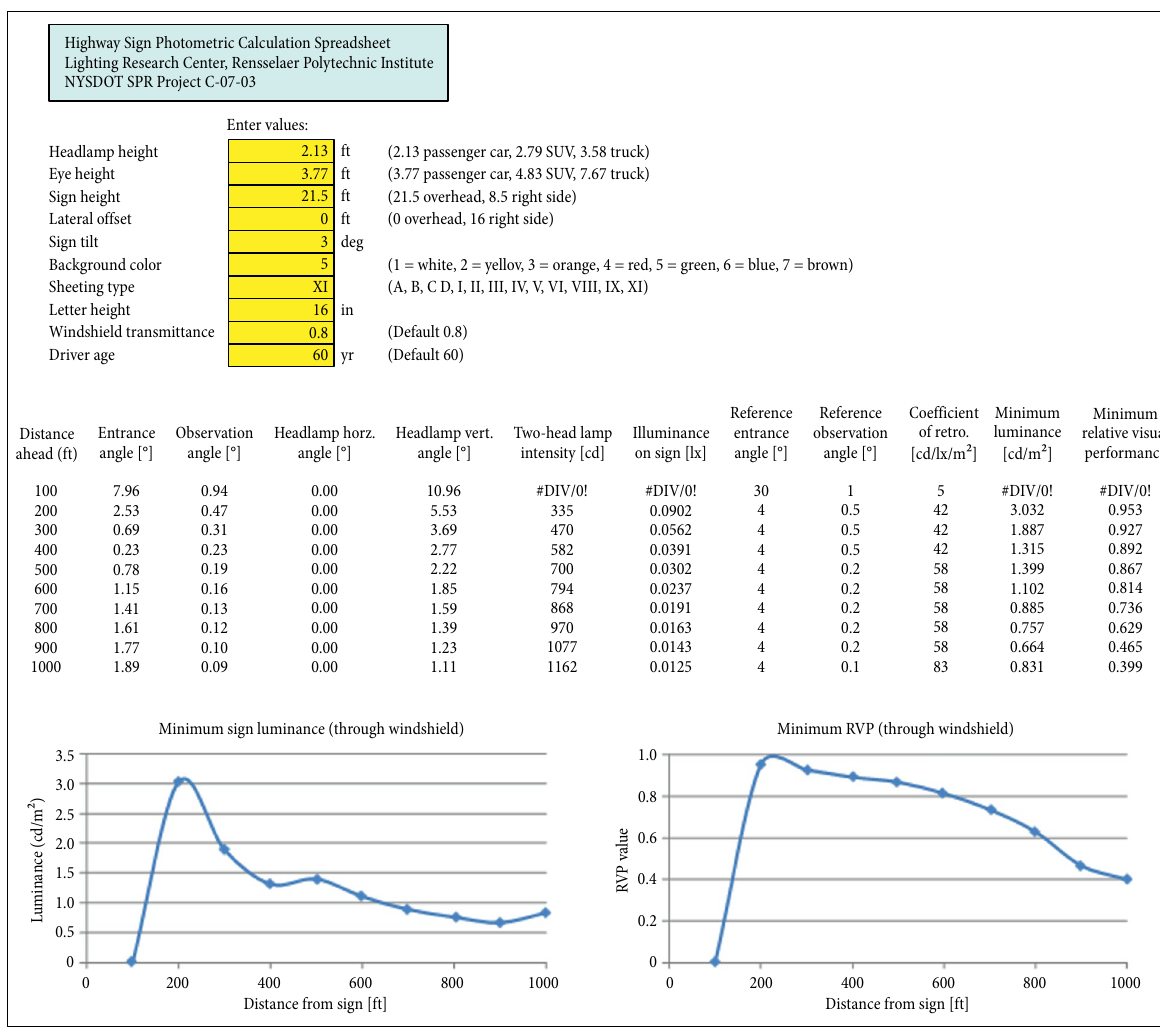
Fig. 6. Main screen of the spreadsheet tool showing calculated luminances and RVP values for a green overhead sign using ASTM D4956-16 type XI